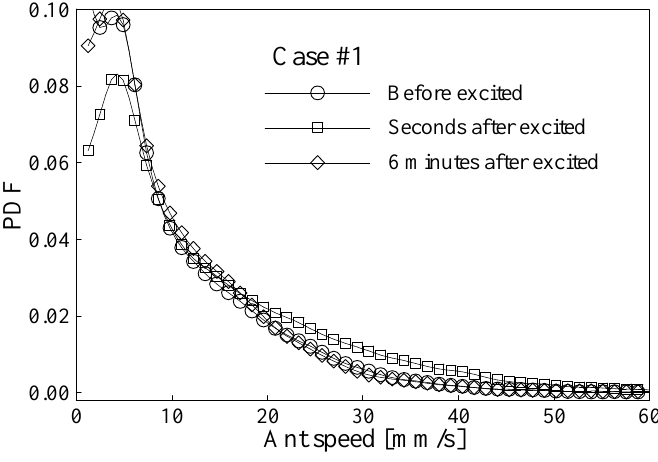
Figure 10. Probability density functions of ant speed for Case #1 at three different test times.